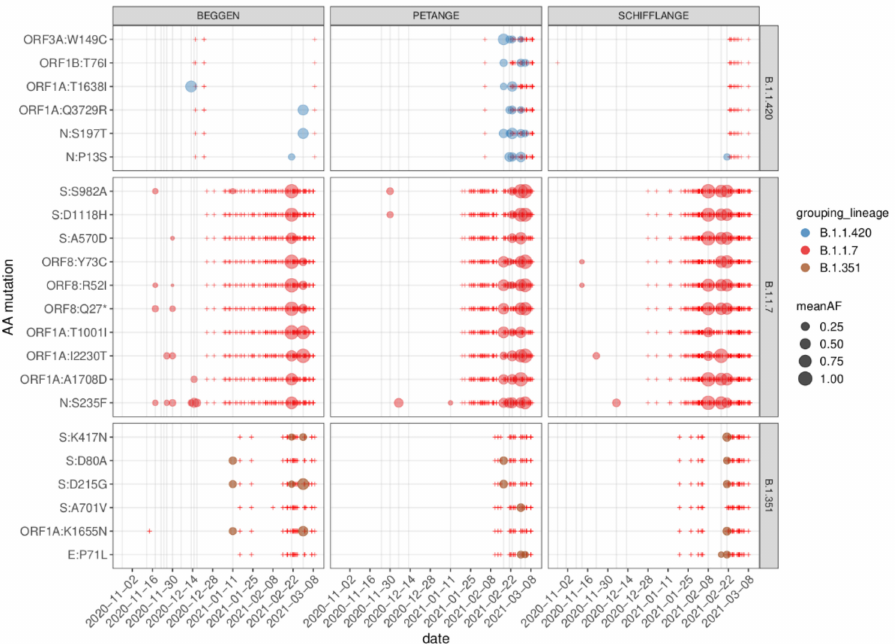
Figure 4. Characteristic mutations unique to specific lineages (B.1.1.420, B.1.1.7 and B.1.351 are shown) grouped according to location. Colored circles indicate presence of the mutation in a wastewater samples, and circle size reflects the allele frequency of the respective mutation(s). Vertical grey lines indicate the availability of wastewater samples. Red crosses indicate the presence of a mutation in a sequence derived from a clinical sample with the patient’s place of residence assignable to the catchment area of the respective wastewater treatment plant. Three locations were selected according to the number of available wastewater samples, and only samples between 1 October 2020 and 9 March 2021 are